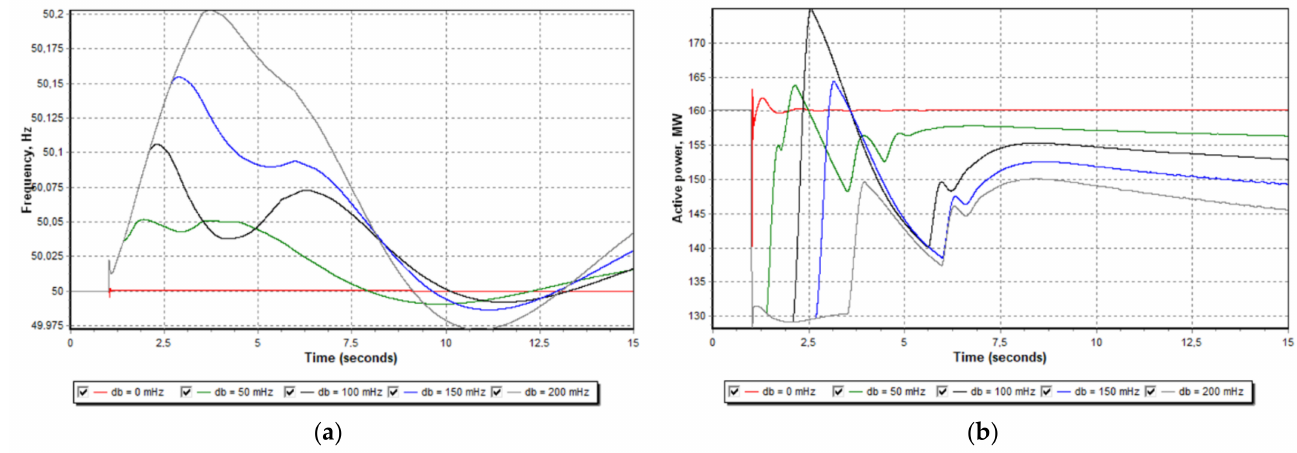
Figure 24. ( a ) Frequency change when the HVDC BtB converter has a different frequency insensitivity range. ( b ) Response of the active power of the HVDC BtB converter to excess